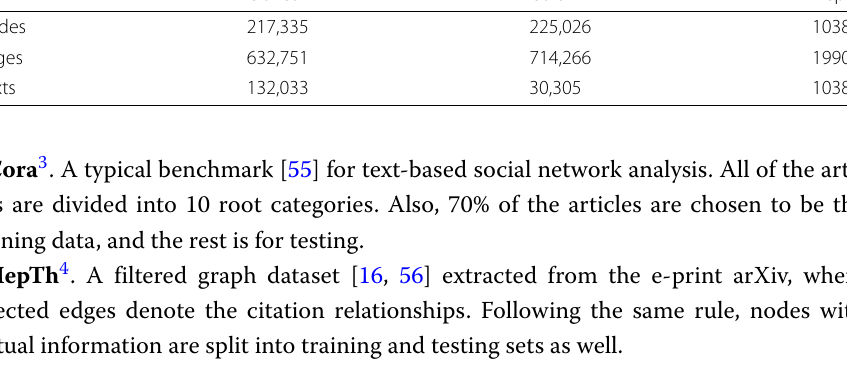
Table 1 Statistics of the datasets CitNet Cora HepTh #Nodes 217,335